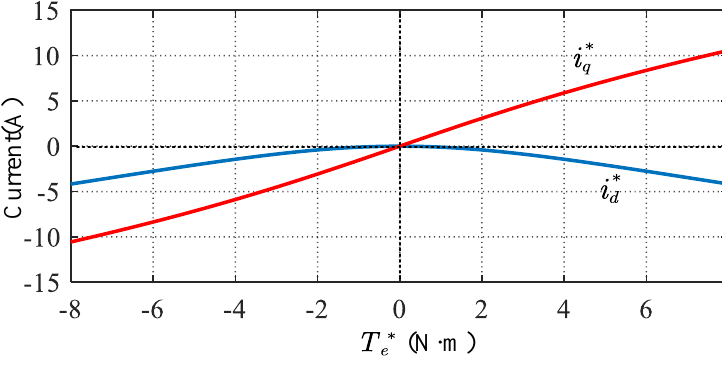
, i ∗ q under MPTA operation i under MPTA operation mode. d T and * i , *